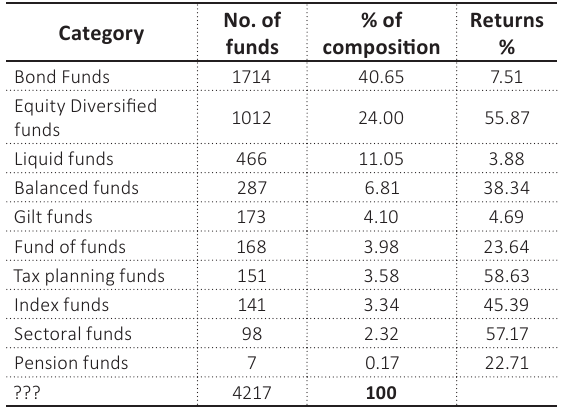
Table 3. Mutual fund returns in different time